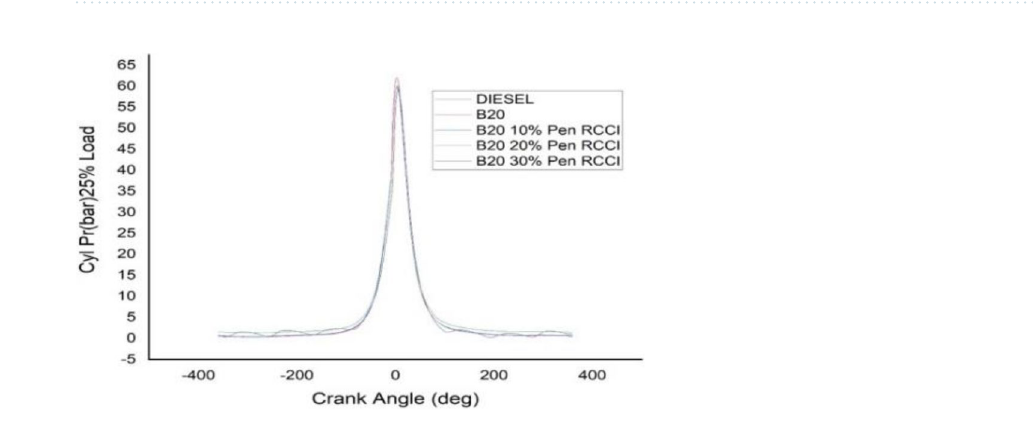
Figure 13. Cylindrical pressure at 0% load.